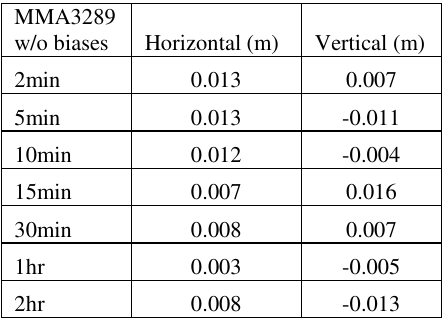
Table 4. Deviations in horizontal and vertical for MMA3289